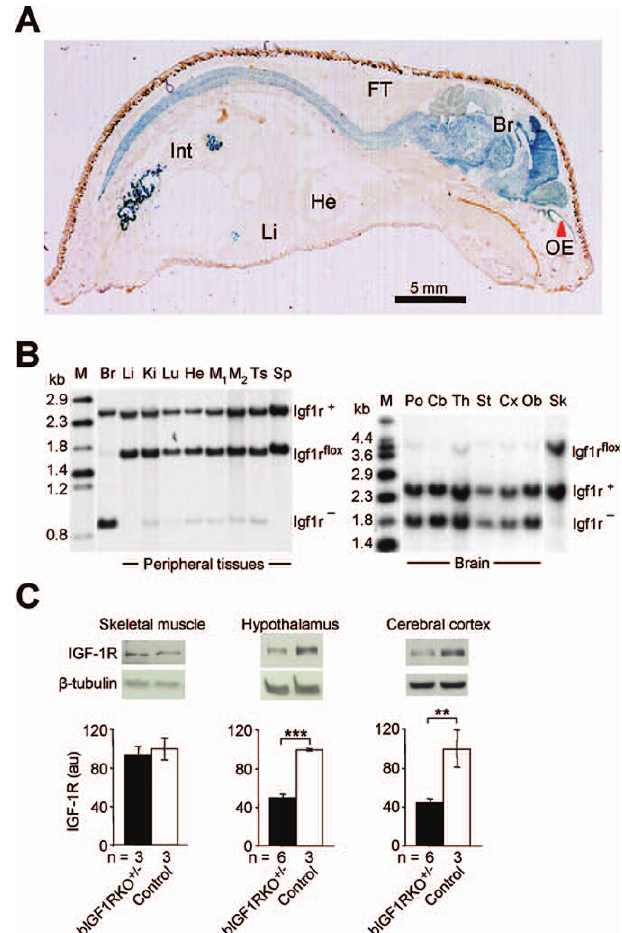
Figure 1. Brain-Targeted Inactivation of the Igf1r Gene Using Cre-lox Mutagenesis (A) CNS-specific Cre-lox recombination demonstrated using X-Gal staining (blue) in a sagittal section from a 2-wk-old NesCre þ /0 mouse harboring a LacZ reporter ( Rosa26R þ /0 ) [33]. NesCre is expressed in neuroepithelium by neuronal and glial precursors. Abbreviations: Br, brain; FT, fat tissue; He, heart; Int, intestine (with bacterial artifacts); Li, liver; OE, olfactory epithelium (red arrow). (B) Southern blot analysis of adult bIGF1RKO þ / (cid:2) tissues revealed complete recombination in the brain (Br) and the intact Igf1r flox allele in all peripheral tissues (left panel). Recombination in peripheral tissues was minimal. The IGF-1R knockout was effective throughout the brain (right panel) and stable through time (unpublished data). The restriction enzymes used were HincII and I-SceI (left blot) and HincII alone (right). Cb, cerebellum, Cx, cortex, Ki, kidney, Lu, lung, M, DNA size marker, M1/ M2, skeletal muscle, Ob, olfactory bulb, Po, pons, Sk, skin, Sp, spleen, St, striatum, Th, thalamus, Ts, testis. (C) bIGF1RKO þ / (cid:2) mice had normal IGF-1R levels in peripheral tissues (e.g., muscle) and ; 50% of normal levels in the CNS (here: hypothalamus and cortex), as assessed by western